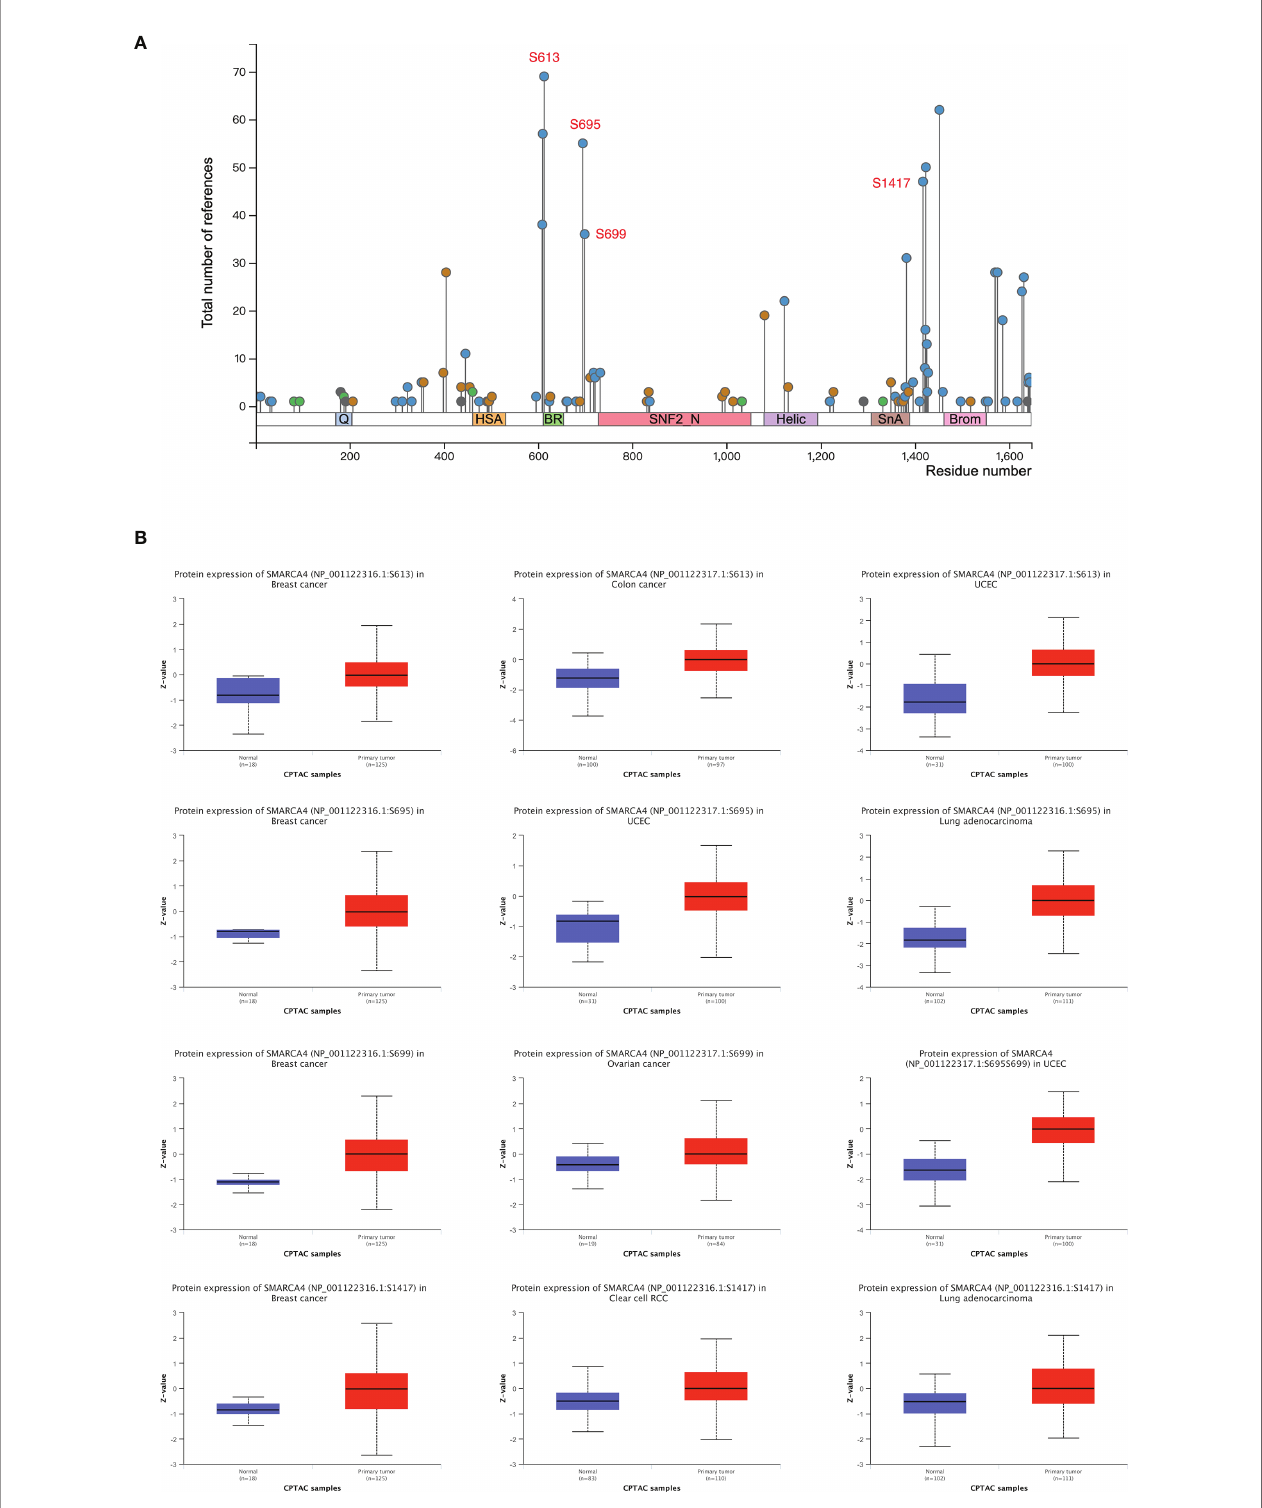
FIGURE 4 | Phosphorylation analysis of SMARCA4 in different tumors. Based on the CPTAC dataset, the expression level of SMARCA4 phosphoprotein was analyzed between normal tissue and primary tissue of selected tumors via the UALCAN. (A) The phosphoprotein sites with positive results are displayed in the schematic diagram of SMARCA4 protein. (B) The box plots for different cancers are